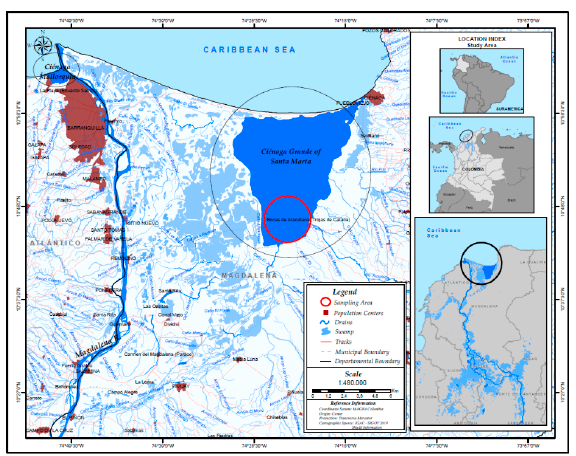
Figure 1. Map of Ci é naga Grande de Santa Marta in Colombia, outlining the study